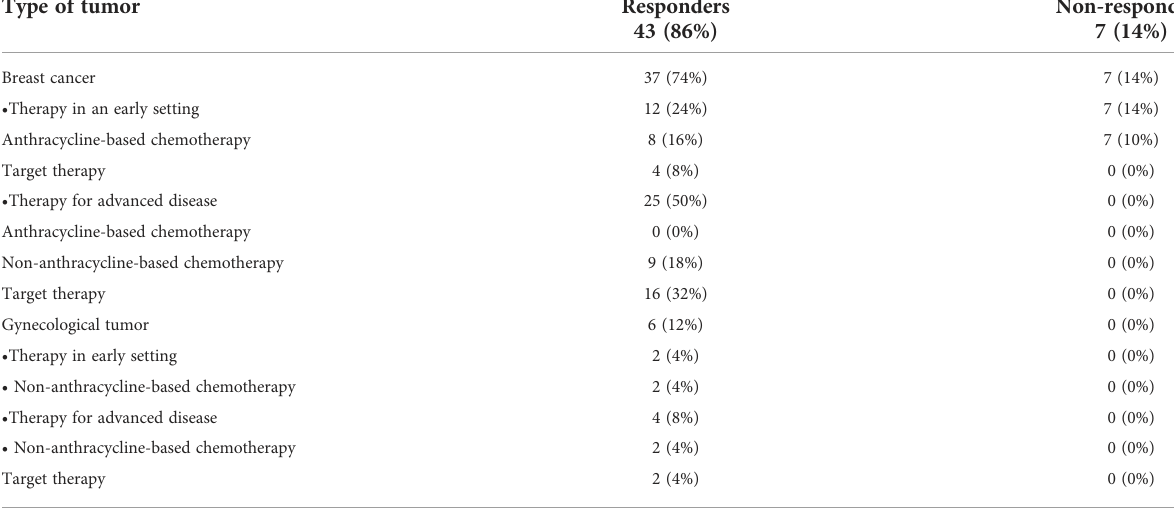
TABLE 2 BNT162b2 COVID-19 vaccine responder rates according to anticancer treatment. Type of tumor